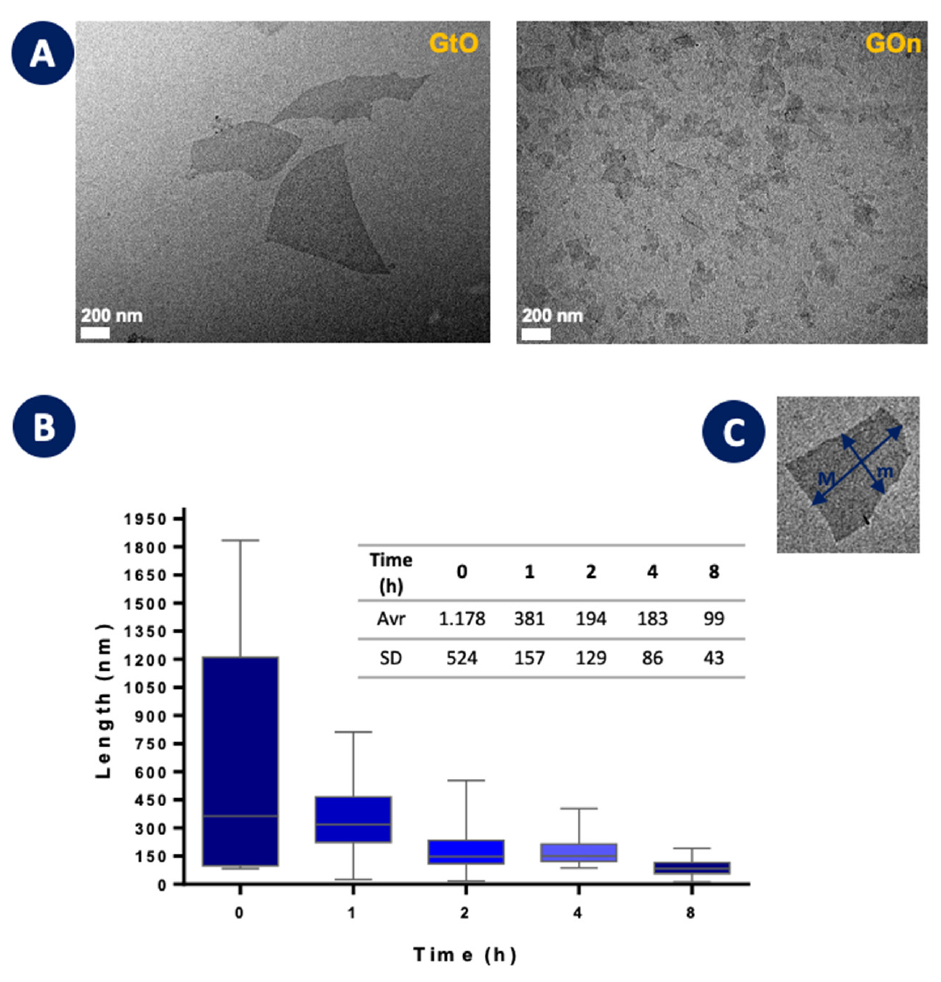
Figure 4. Effect of high-power ultrasonication time on the particle size of GOn. ( A ) TEM images comparing starting GtO particles and the GOn sheets obtained after 8 h of high-power ultrasonication. ( B ) Box plot of particle sizes and average and standard deviations (SD). ( C ) Representation of the major (M) and minor (m) axis used for calculation of average lateral dimensions from TEM images.